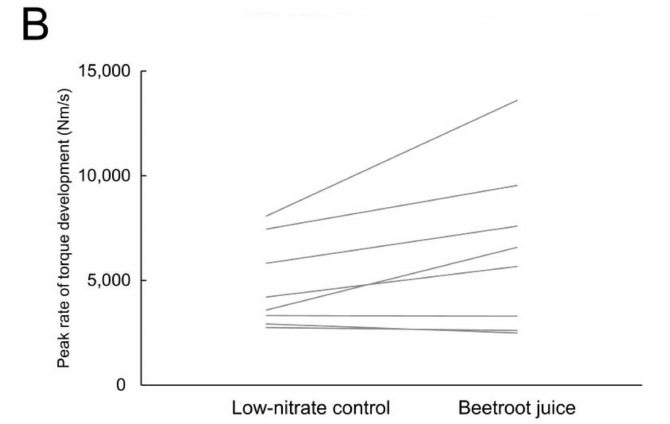
Figure 3. Individual responses regarding peak rate of torque development for female ( A ) and male ( B ) participants.